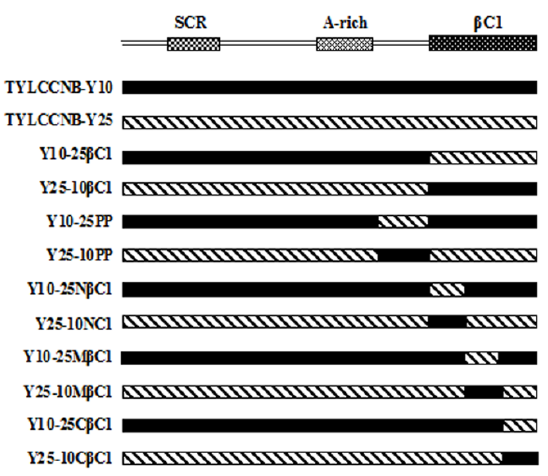
Figure 8. Schematic representation showing the organization of hybrid betasatellites. Betasatellite organization is shown as linear DNA in the complementary sense. SCR, satellite conserved region; A-rich, adenine-rich; βC1, βC1 gene; TYLCCNB-Y10, tomato yellow leaf curl China betasatellite-Y10; TYLCCNB-Y25, tomato yellow leaf curl China betasatellite-Y25.